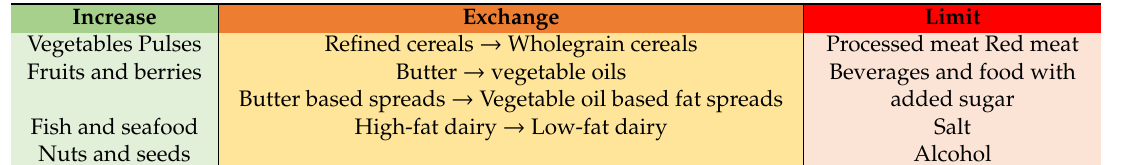
Table 1. The Nordic Food-Based Dietary Guidelines for dietary changes that promote energy balance and health in Nordic populations 1